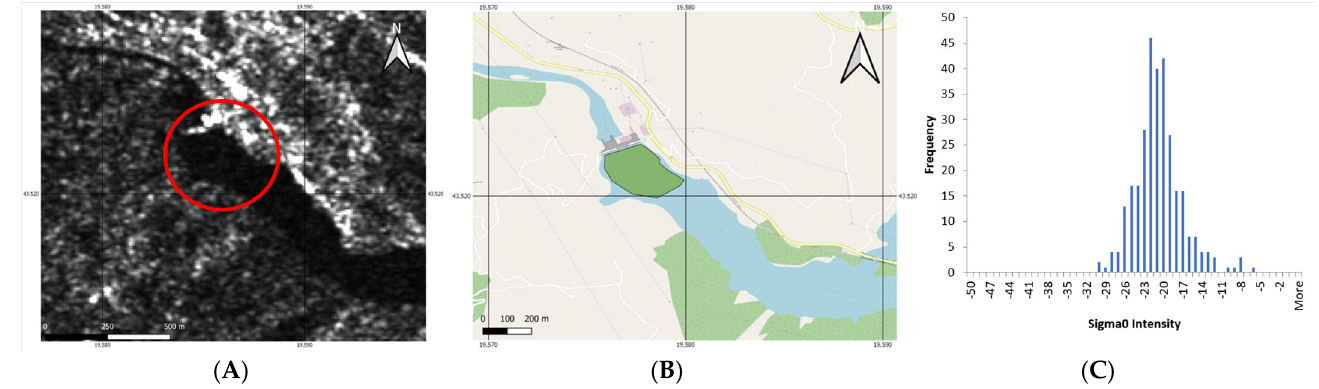
Figure 5. Image from 5 May 2020 in Sentinel ‐ 1 VV channel showing Potpecko Lake hydroelectric dam, Serbia. ( A ) VV Intensity with red marker highlighting dam, ( B ) Polygon used for histogram, and ( C ) Histogram of pixels in polygon (Sentinel ‐ 1, Credits: ESA).